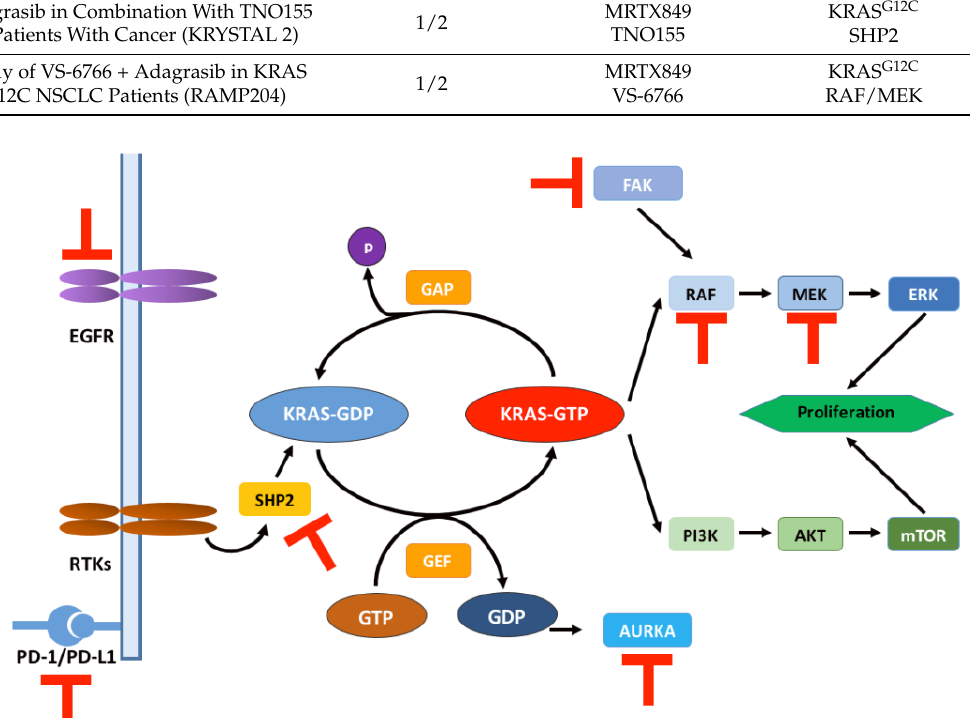
Figure 3. Schematic representation of the RAS signaling pathway and relevant targets for combination therapy regimens. T symbol in red: therapeutic targets combined with KRAS G12 inhibitors in clinical trials (Table 1). RTKs: receptor tyrosine kinases; AUKRA: aurora kinase A; FAK: focal adhesion kinase. MAPK-ERK and PI3K-AKT-mTOR pathways are two important RAS downstream signaling pathways, and their signaling is regulated by RAS proteins [96]. Notably, the PI3K-AKT-mTOR pathway is not only regulated by RAS proteins, but also by